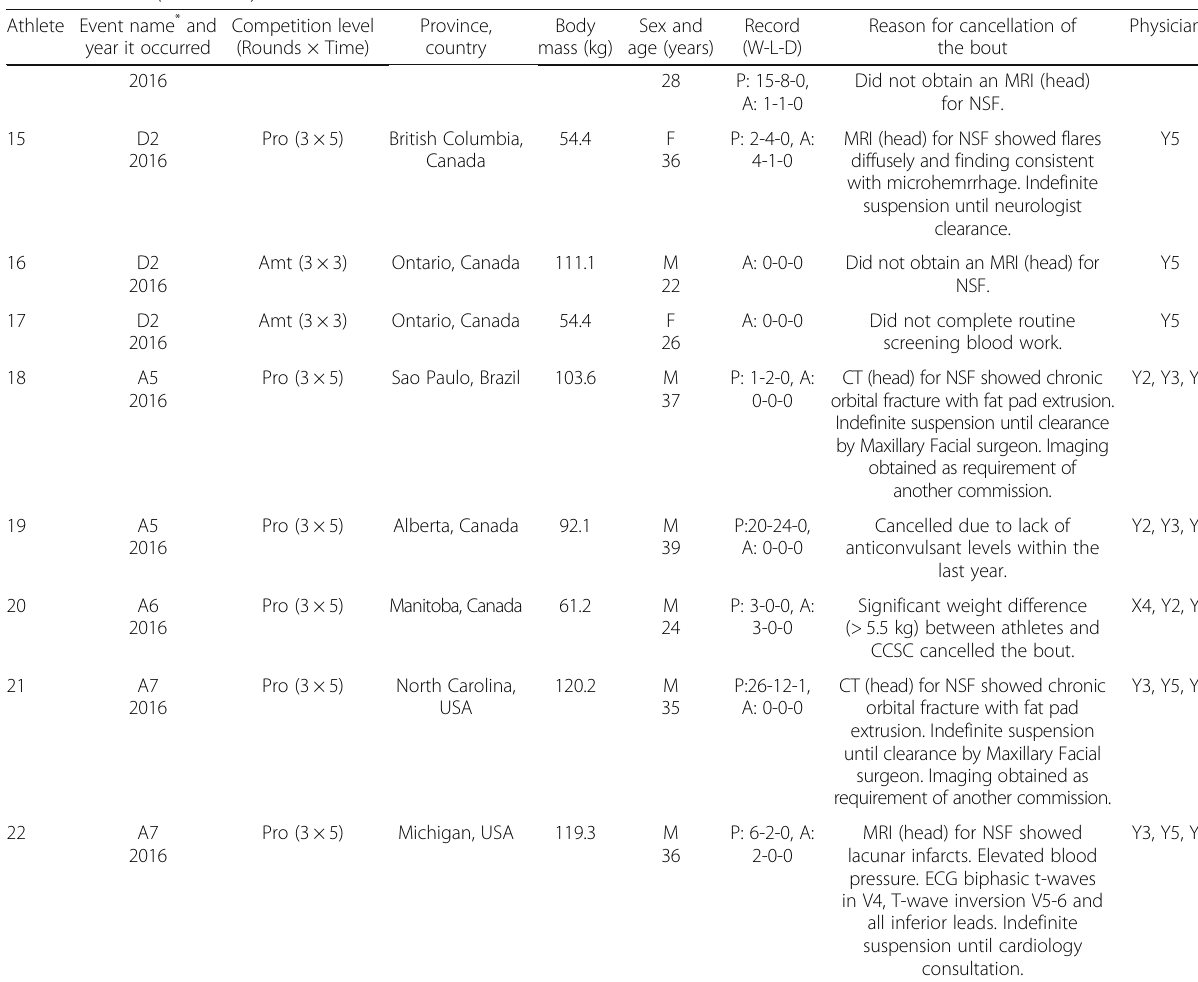
Table 1 Medical reasons and characteristics of athletes involved in cancelled bouts in Calgary, Alberta, from January 2010 – December 2016 (Continued)